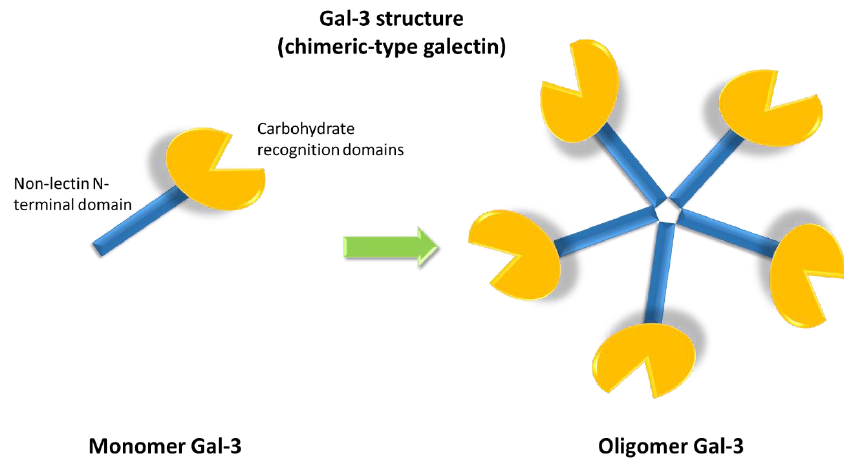
Figure 1. Galectin-3 (Gal-3) chimeric structure characterized by a carbohydrate recognition domain and a non-lectin N-terminal domain that promotes oligomerization, allowing for the formation of